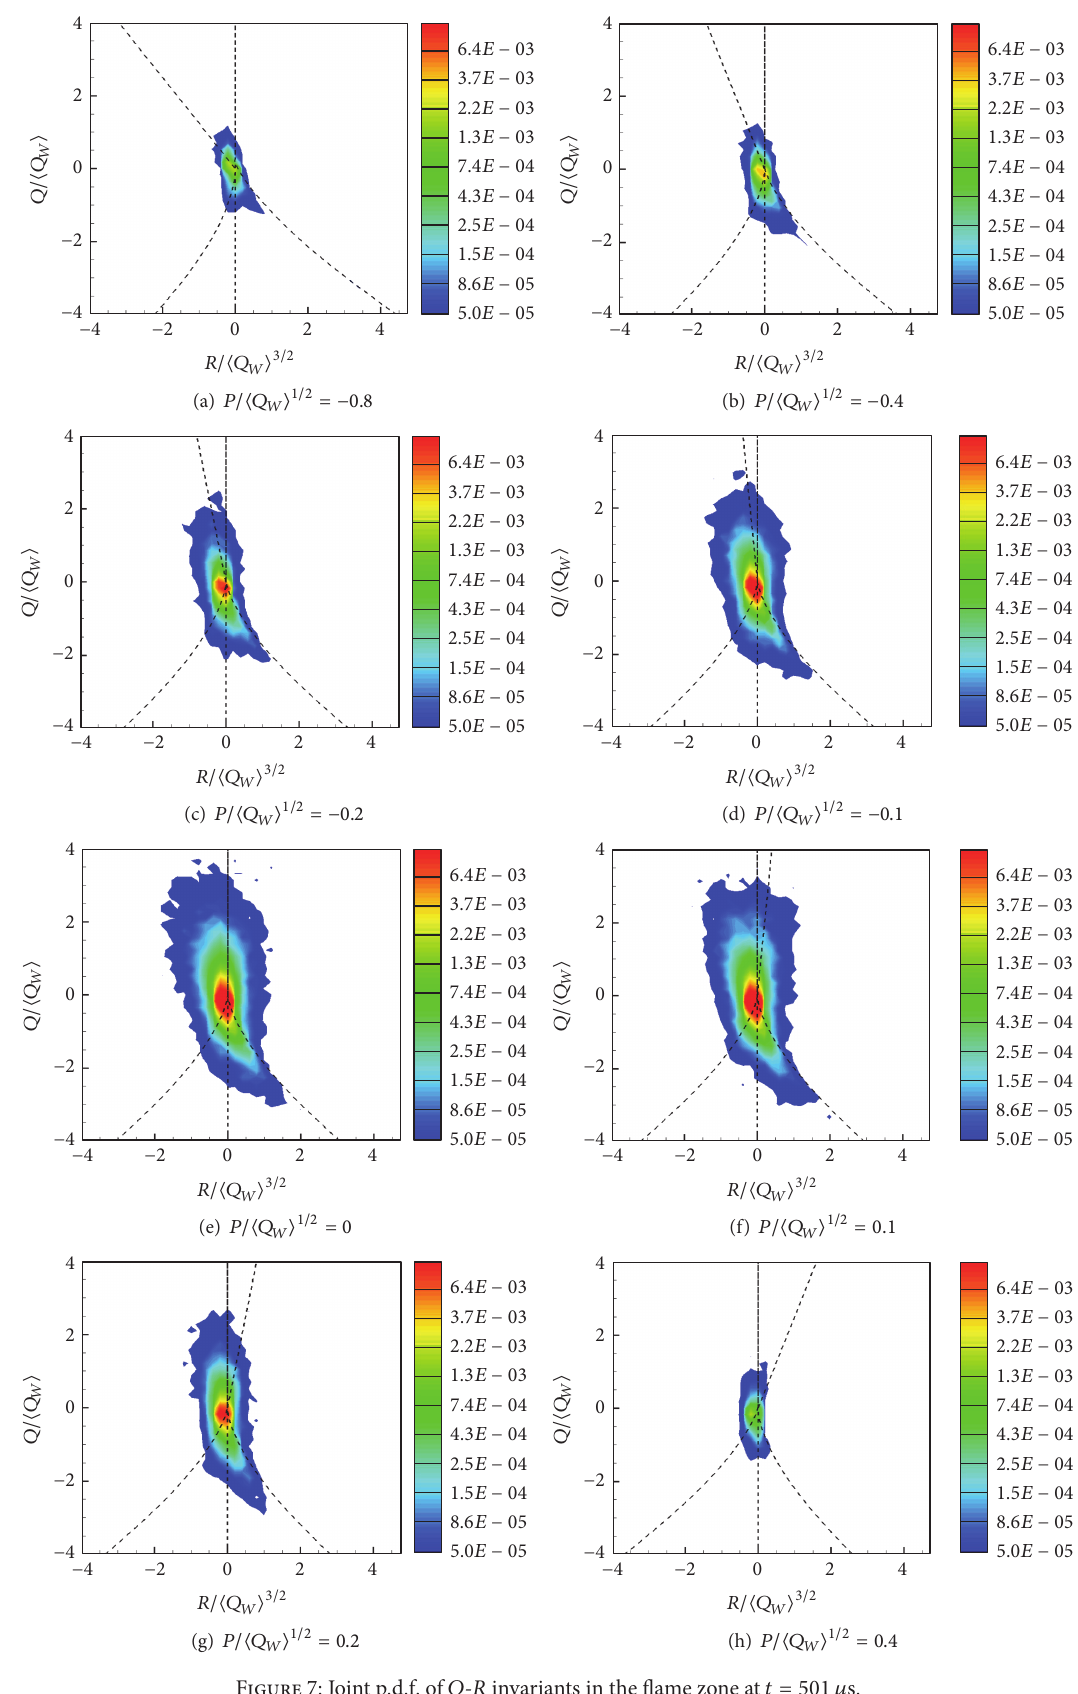
Figure 7: Joint p.d.f. of 𝑄 - 𝑅 invariants in the flame zone at 𝑡 = 501 𝜇